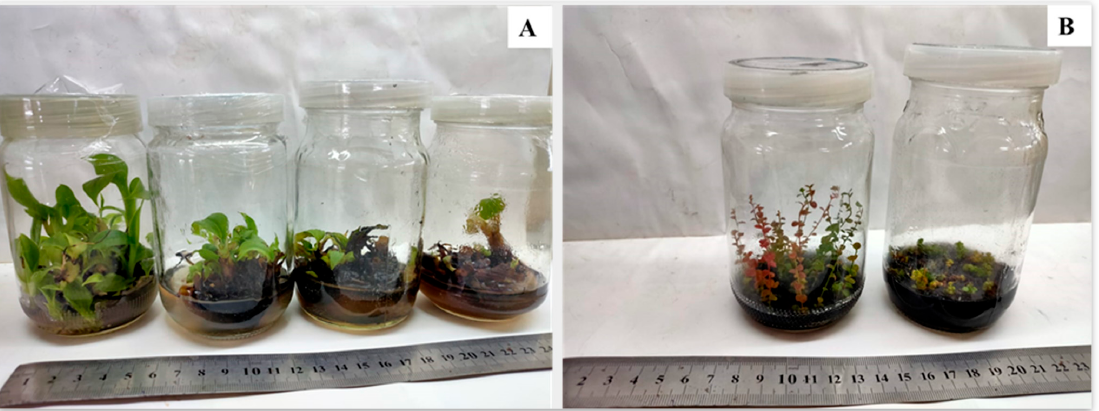
Figure 4. Effect of too-high temperature forceps and scalpels during sterilization on in vitro shoot multiplication and growth of burned plants. Photo ( A ) represents banana plant ( Musa sp.) and ( B ) blueberry plant ( Vaccinium corymbosum L.).